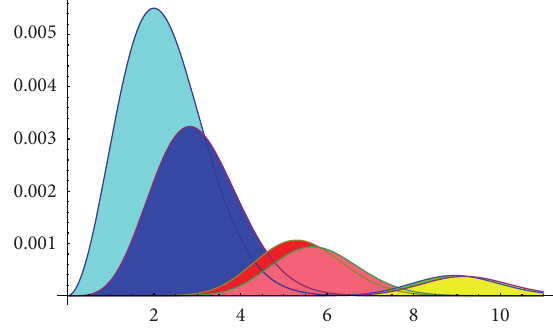
Figure 2: Plot of the radial density profile 𝜌(𝑟) as a function of 𝑟 in √𝜃 -units for 𝑘 = 1 (cyan), 𝑘 = 2 (blue), 𝑘 = 7 (red), 𝑘 = 8 (pink), 𝑘 = 20 (green), and 𝑘 = 21 (yellow). The function 𝜌(𝑟) has been normalized so that its integration over a spherical volume gives